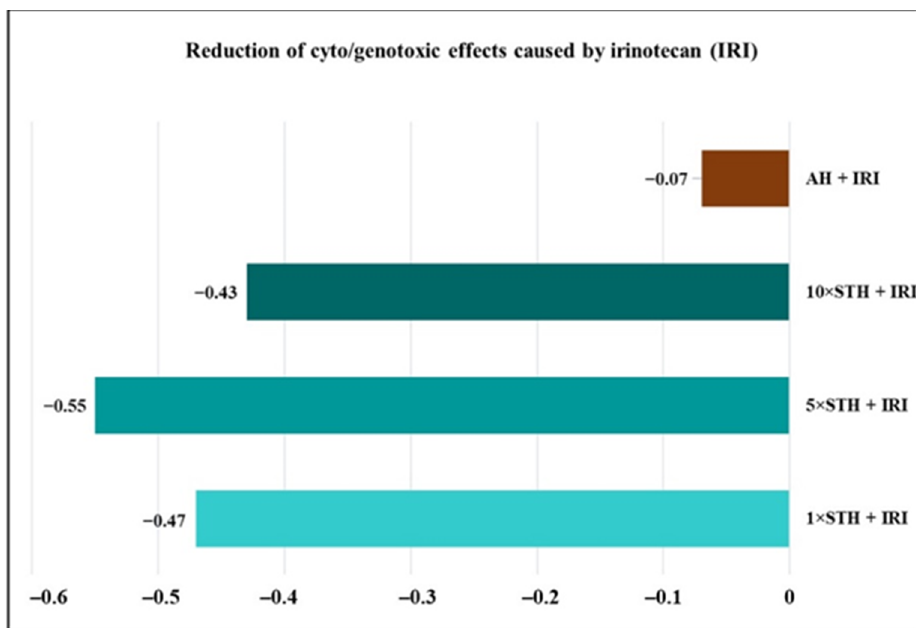
Figure 3. Influence of strawberry tree honey (STH), artificial honey (AH), and strawberry tree honey phenolic extract (E) on the reduction in cyto/genotoxic effects caused by irinotecan (IRI).